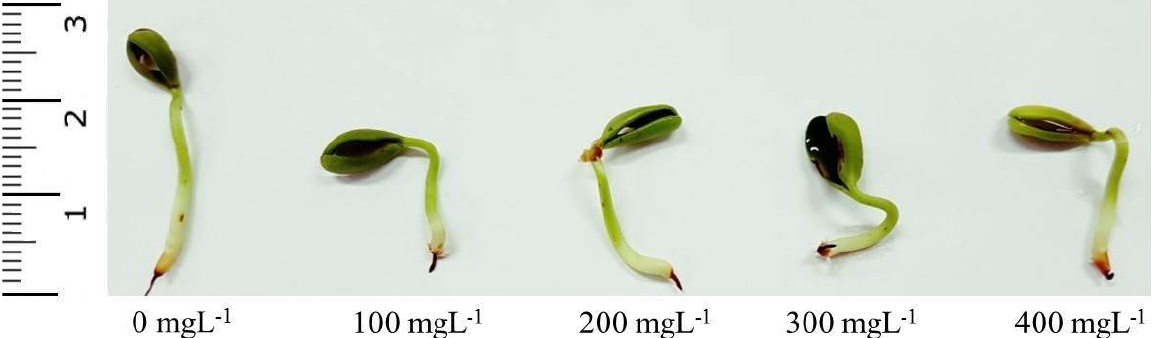
Figure 6. Size of root at Sesbania virgata, with different concentrations of CuO NPs. Photo: Eliene